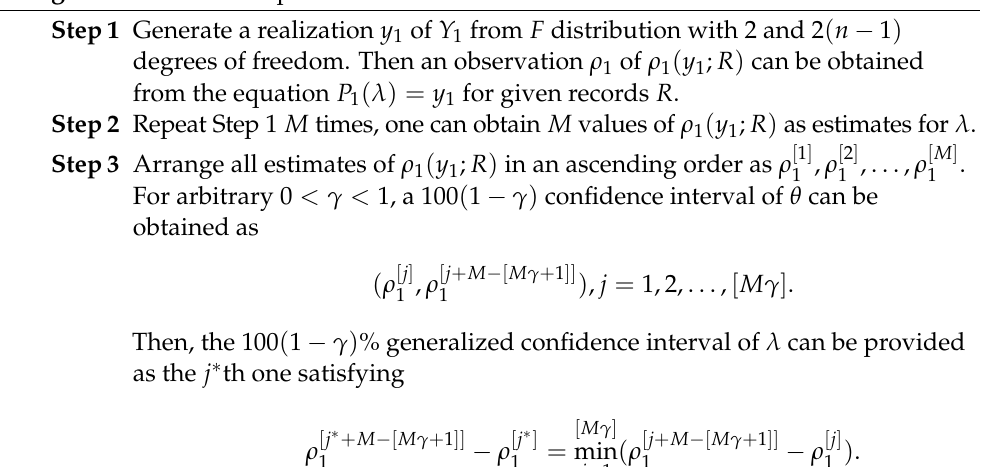
Algorithm 2: FGCI for parameter λ